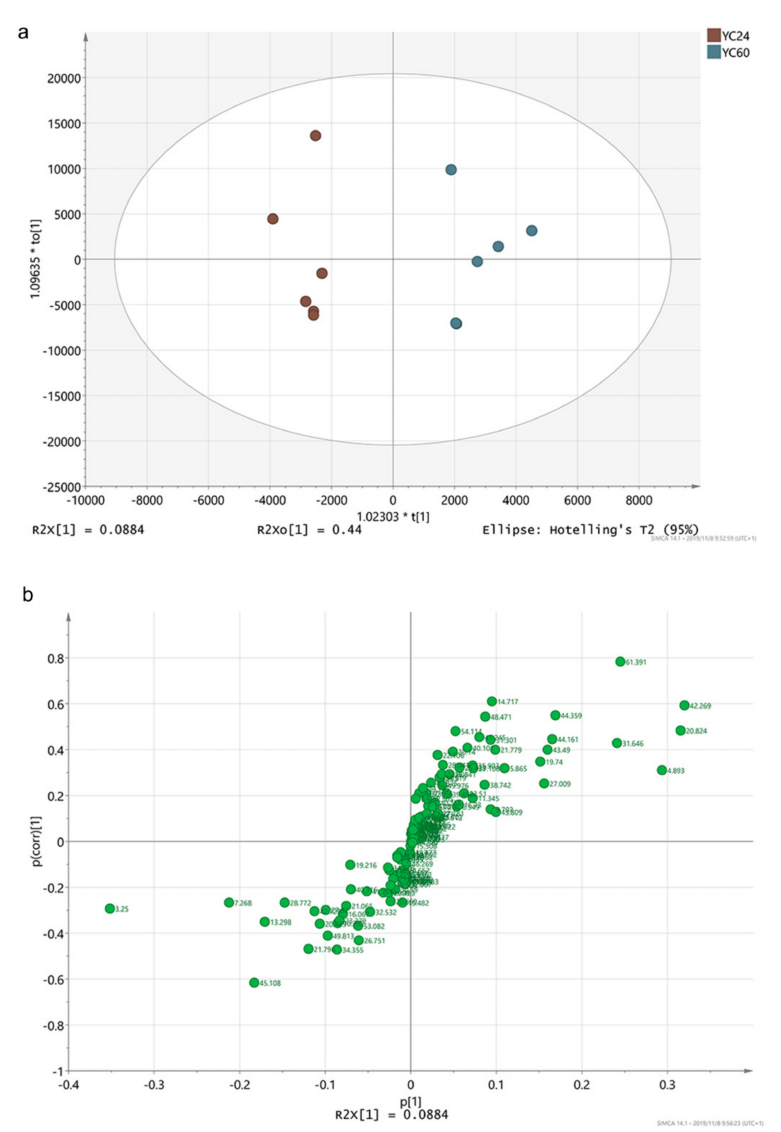
Figure 3. ( a ) Two-dimensional orthogonal partial least squares discriminant analysis (OPLS-DA) score map; ( b )